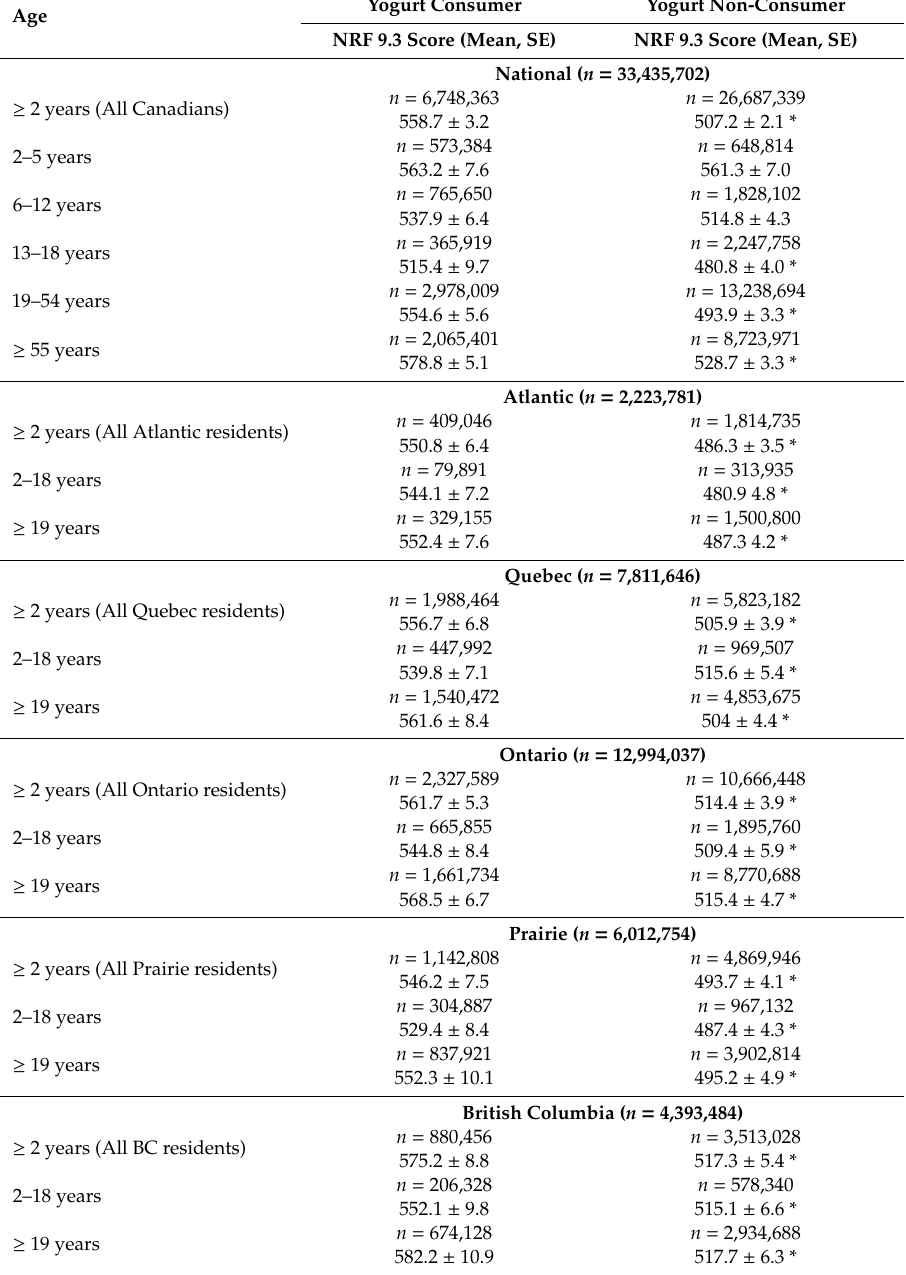
Table 5. The NRF 9.3 score of yogurt consumers and non-consumers across Canada (all ages, 5 age groups) and regions (all ages and 2 age groups) 1